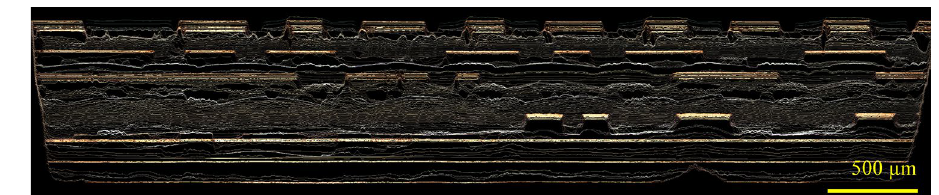
Figure 14. Cross sectional view of the volumetric image data as collected by the confocal microscope at different layers throughout the consecutive delayering/imaging procedure. The aspect ratio is